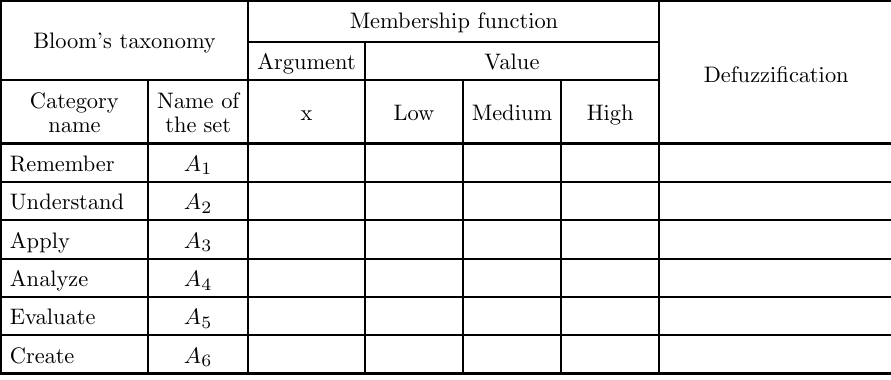
Membership function